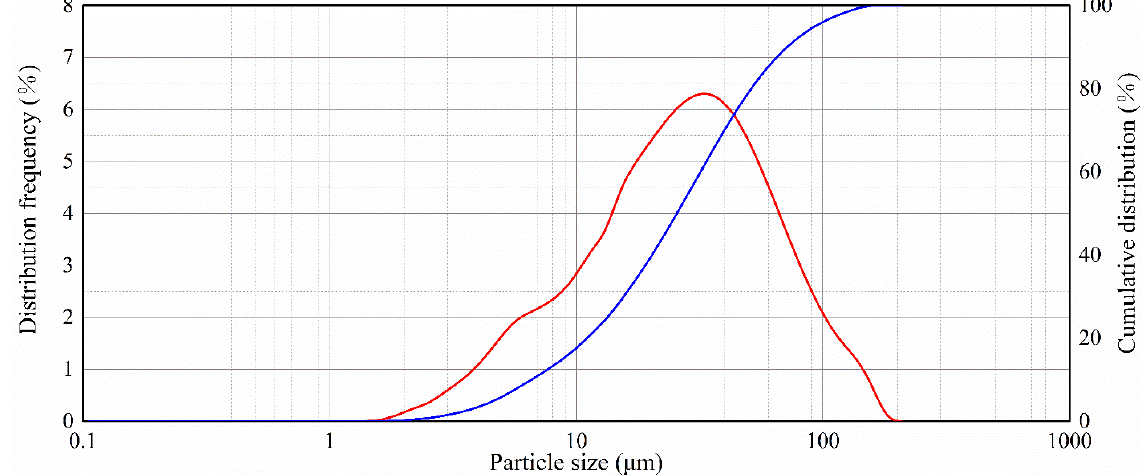
Figure 14. Particle size analysis report for the calcium carbonate raw material.